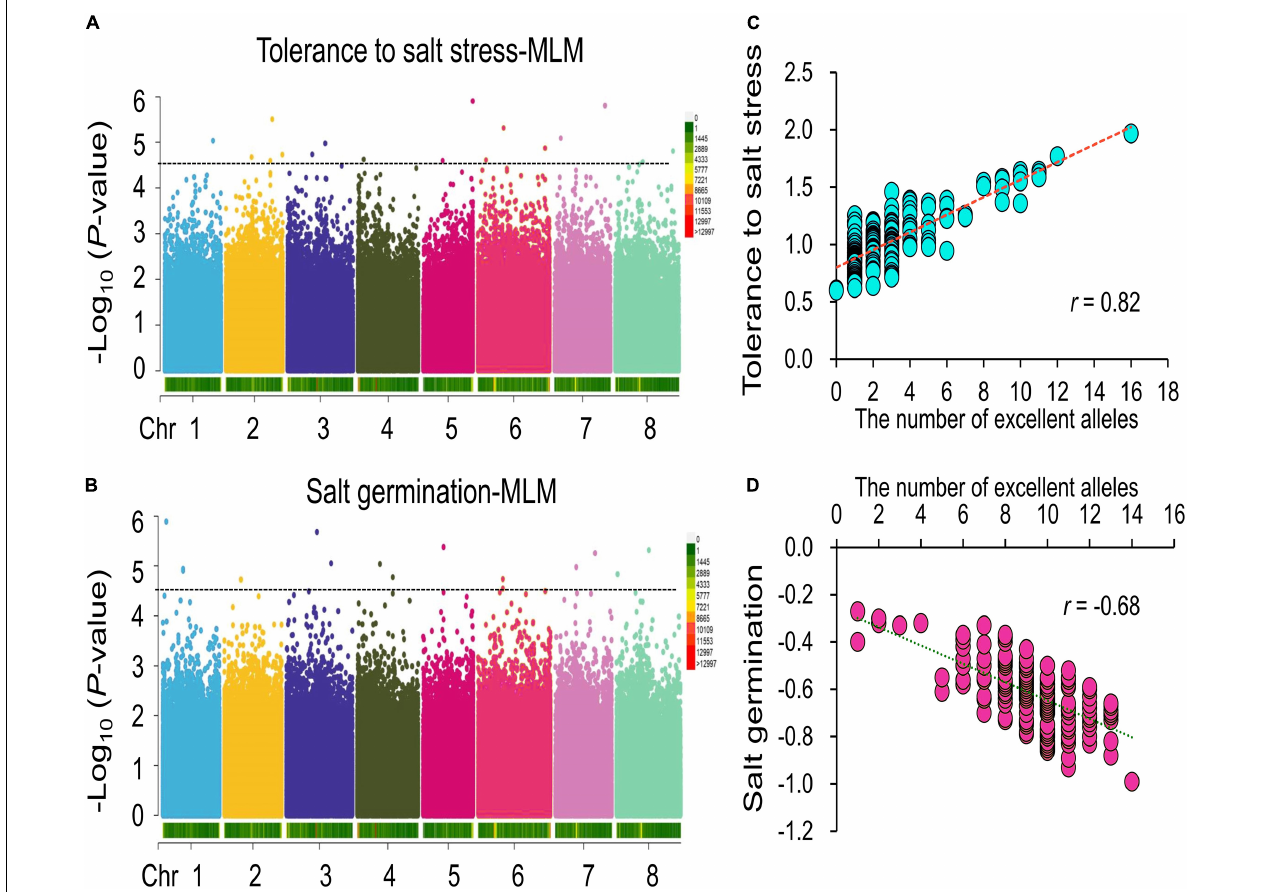
FIGURE 2 | GWAS of tolerance to salt stress and germination ability under salt stress. (A,B) , Manhattan plots of the GWAS results of the tolerance to salt stress and germination ability under salt stress among the association panel. (C,D) , Correlations between phenotypic traits (C) for tolerance to salt stress and (D) for germination ability under salt stress and number of excellent alleles identified by the GWAS